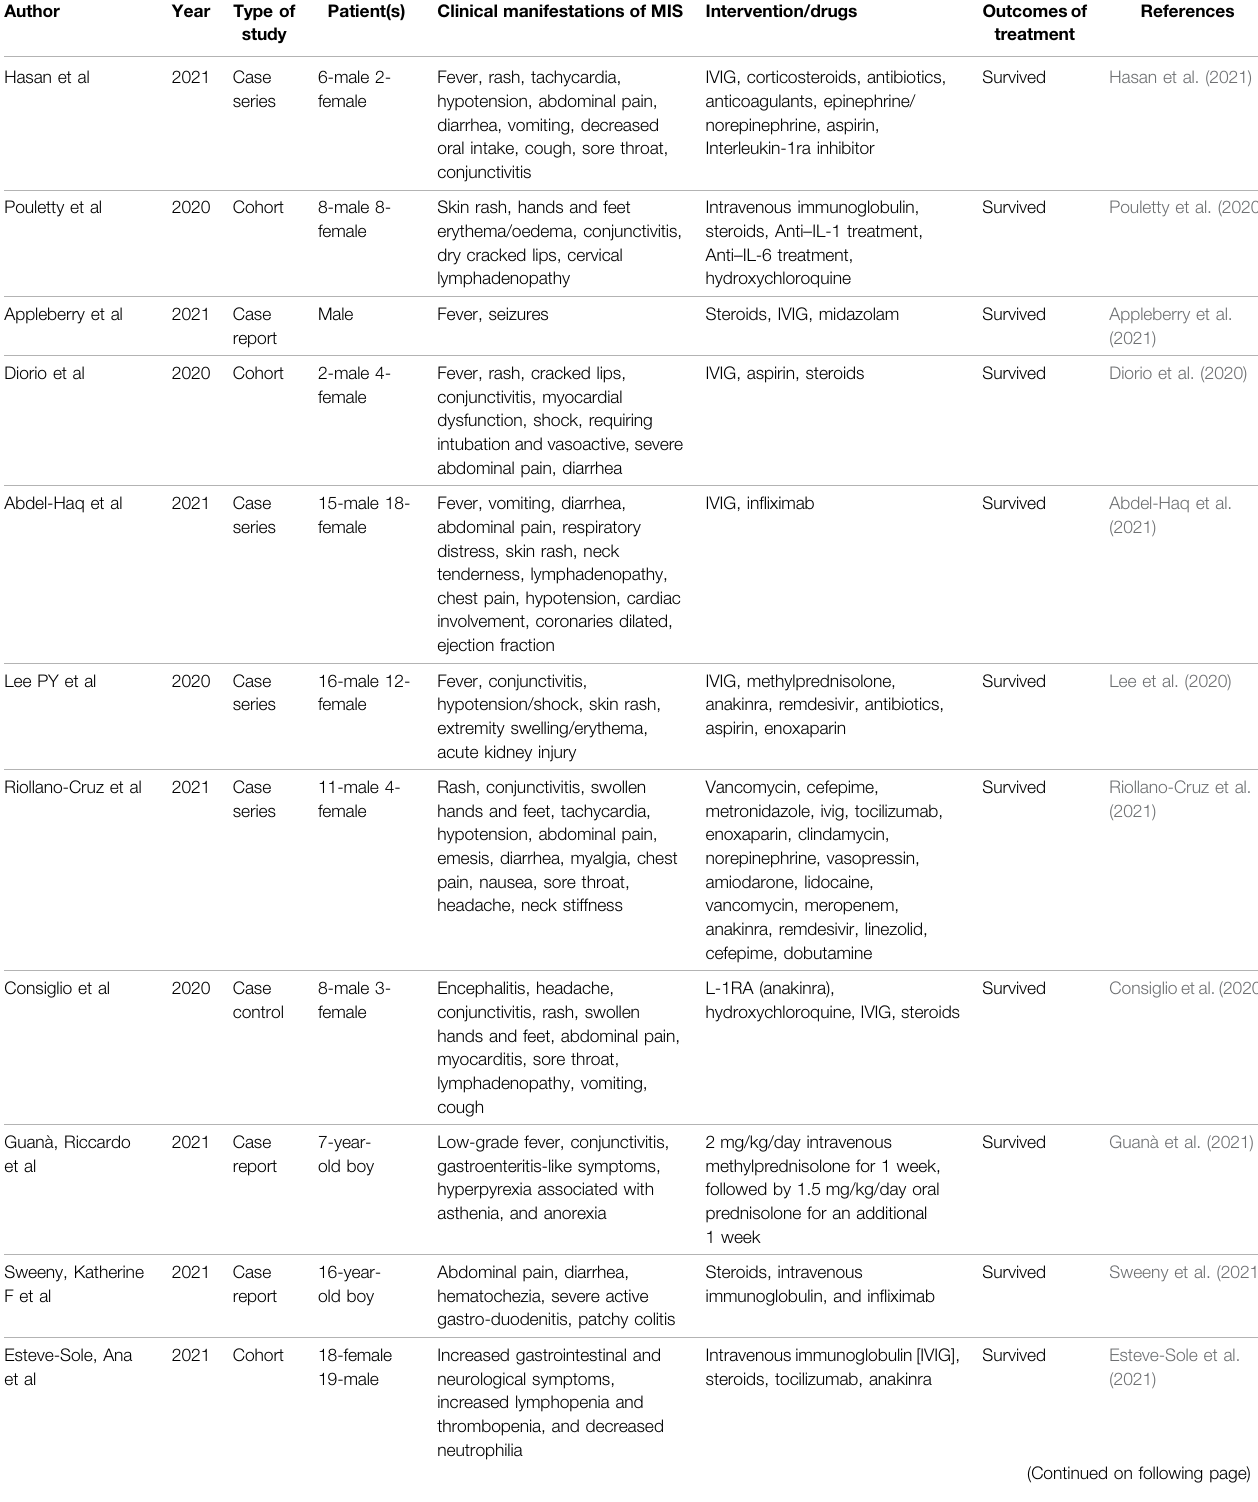
TABLE 1 | Summary of studies on the therapeutic options for multi-system in fl ammatory syndrome following SARS-CoV2